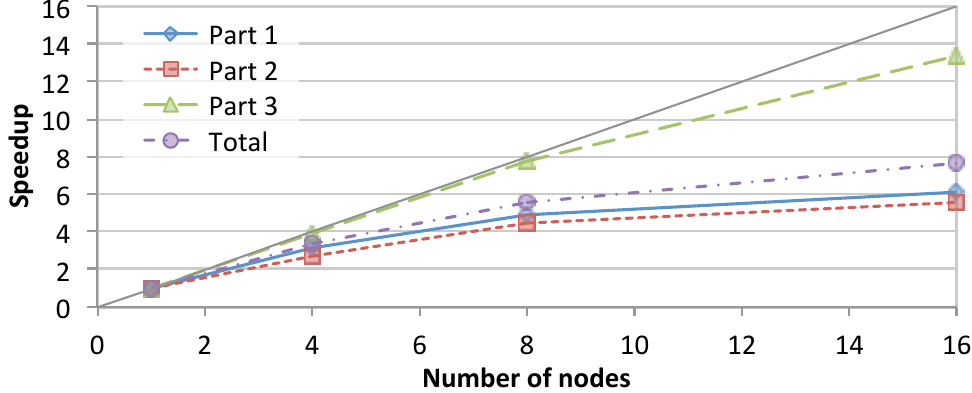
Figure 7. Speedup achieved by SparkRA and its parts when running on 1, 4, 8 and 16 nodes in the cluster.